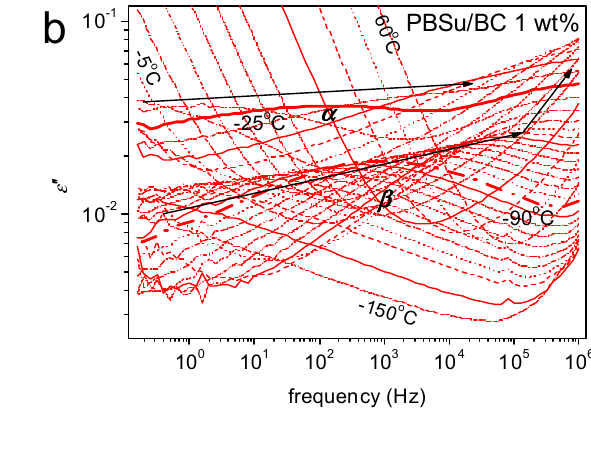
Figure 8. Effects of composition on (left axis, black diamonds) crystalline fraction, comparatively with (right axis, blue circles) crystallization temperature and (orange columns) thermal conductivity (LFA).